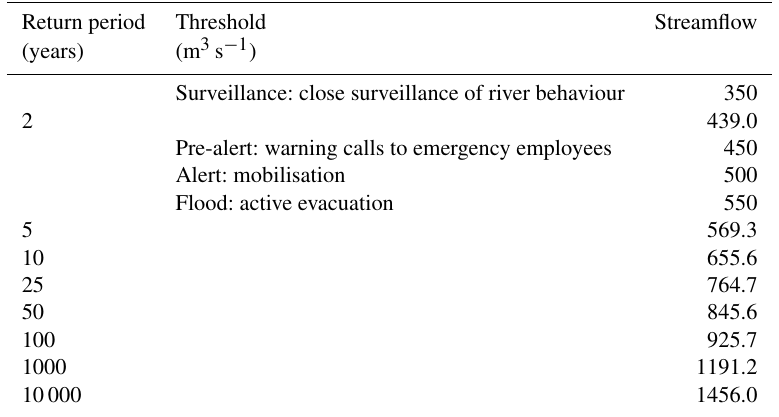
Table 1. Streamflow associated with important return periods and flood mitigation thresholds for the Montmorency River